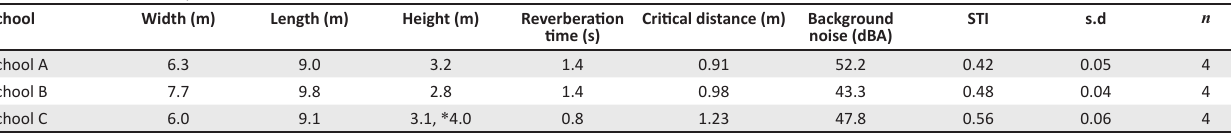
TABLE 2: Classroom